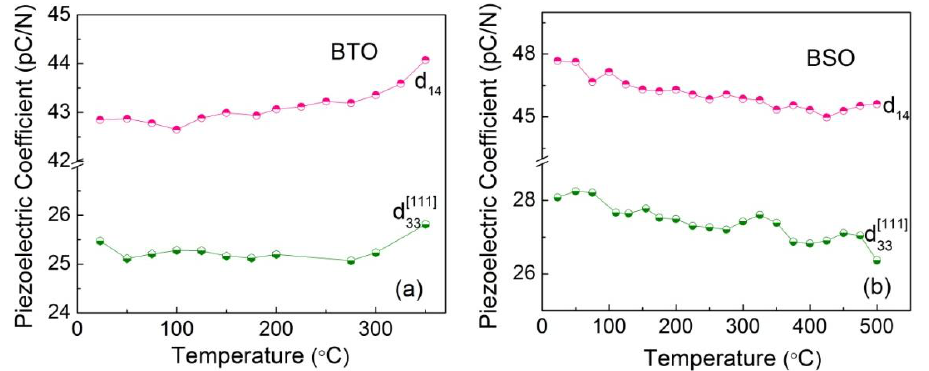
Figure 8. Piezoelectric coefficients as a function of temperature for BTO and BSO crystals.